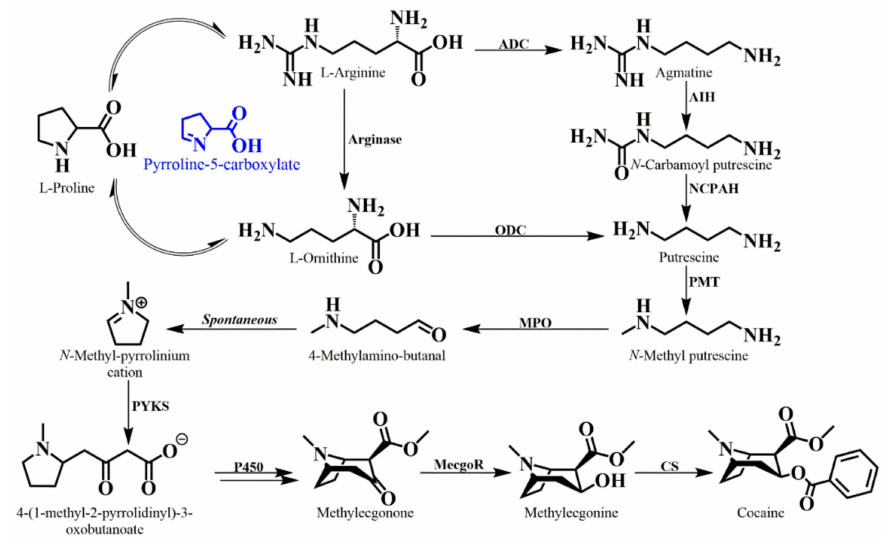
Figure 8. The theoretical tropane alkaloid biosynthetic pathway in E. coca . The name of each enzyme, along with their respective acronyms, and corresponding GenBank accession numbers are